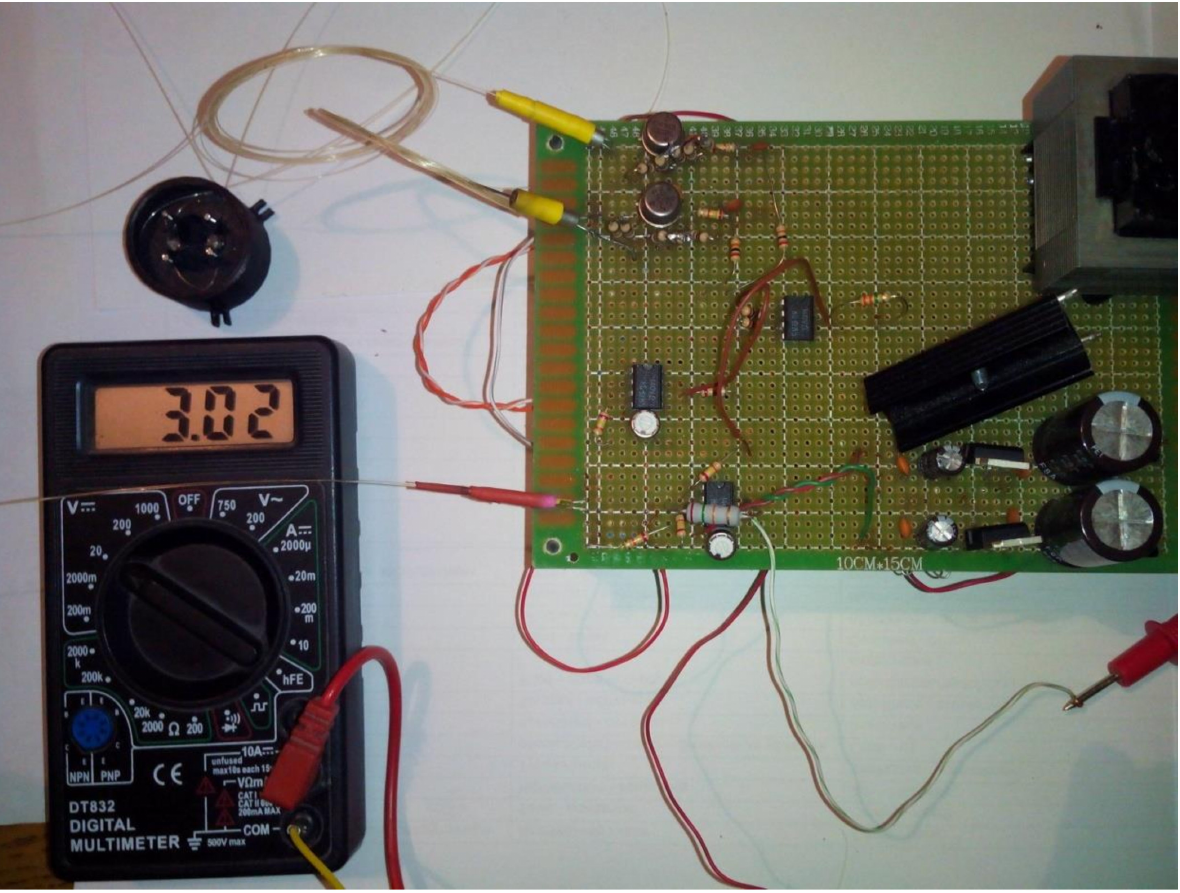
Figure 12. Mock-up experimental prototype FOIMS, including prototype FOAS connected to